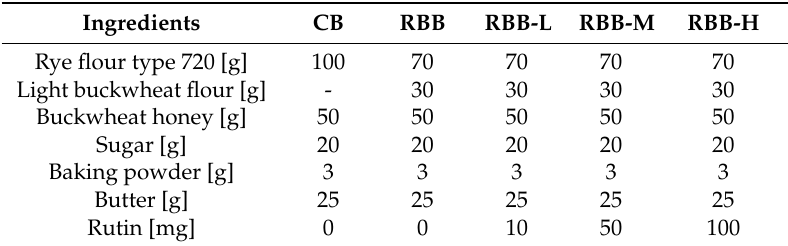
Table 5. Rye-buckwheat biscuit formulas with increasing rutin